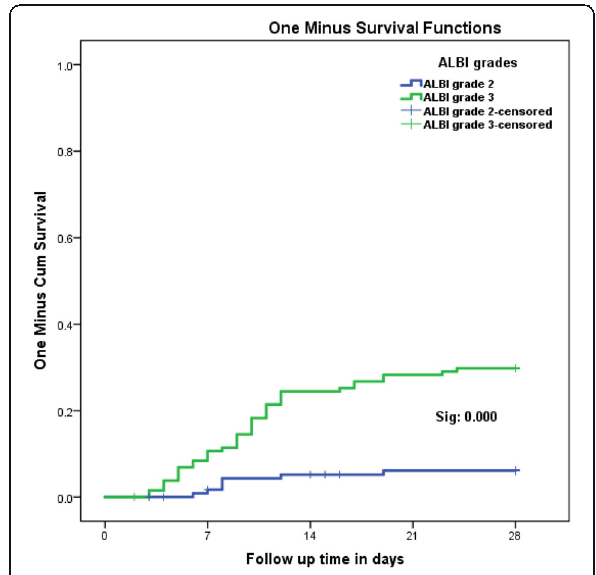
Fig. 2 ROC curve for ALBI, Child-Pugh, and MELD scores in prediction of hepatic encephalopathy